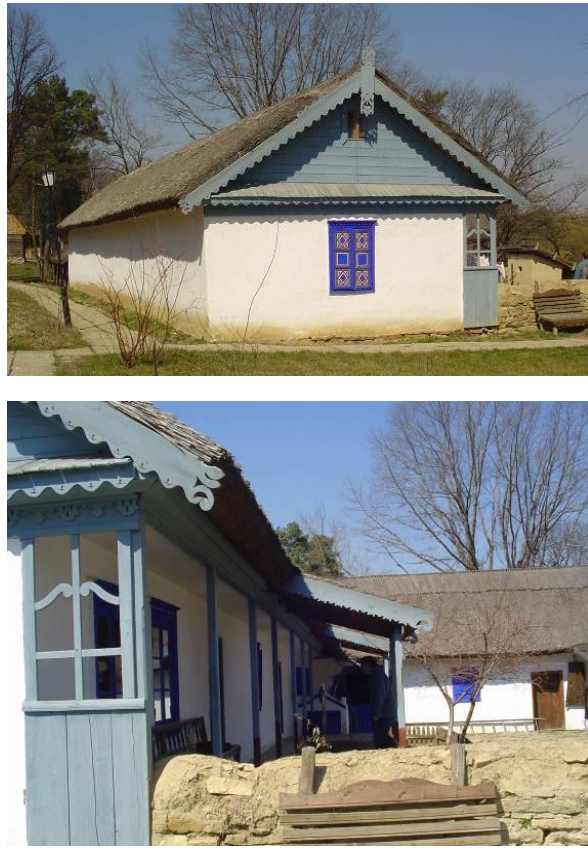
Figure 7. House in Jurilovca – 17th Century (in the Village Museum in Bucharest).